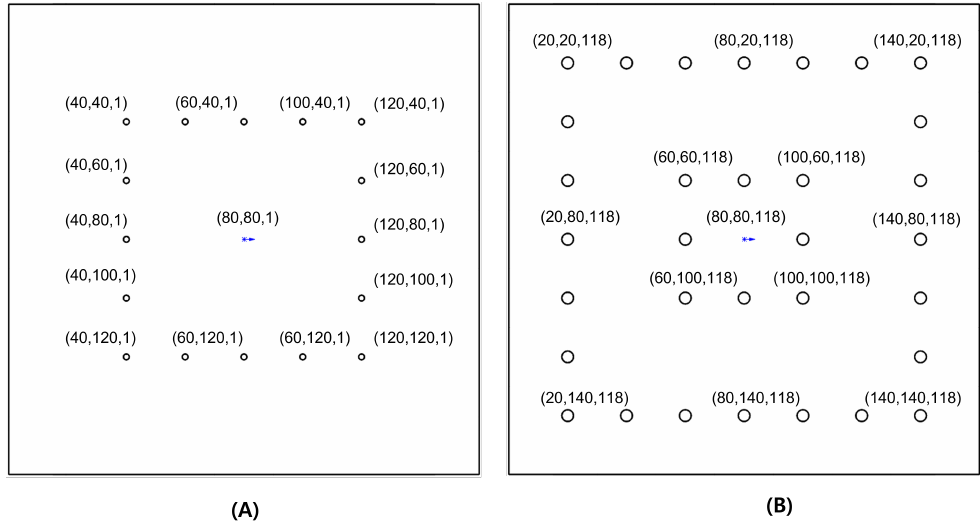
Figure 2. Two-dimensional drawings of the top and bottom layers of the phantom. The brackets represent the 3D coordinates of the center of each ball bearing, in mm. ( A ) is the lower layer with 2 mm diameter ball bearings, and ( B ) is the upper layer with 4 mm ball